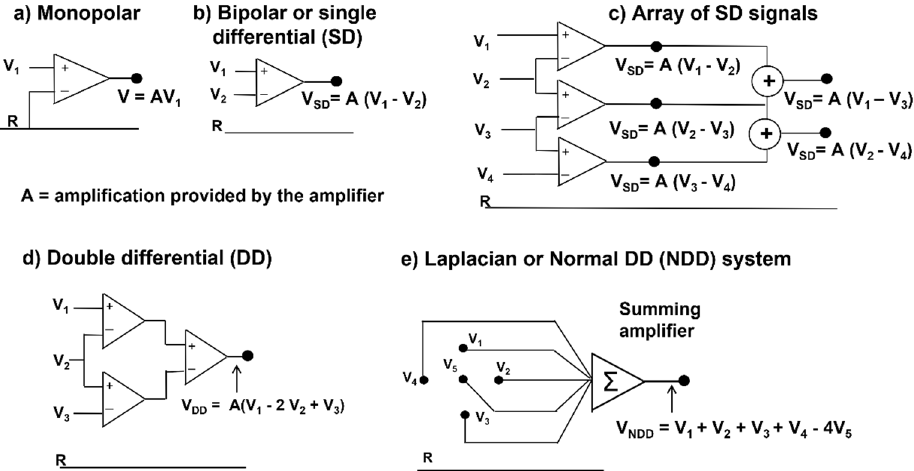
Figure 16. Electrode configurations or “montages”: ( a ) monopolar (any combination or spatial filter can be obtained by a grid of monopolar signals); ( b ) bipolar or single differential (SD); ( c ) array of SD signals; ( d ) double differential (DD); ( e ) normal (perpendicular) DD (NDD) or Laplacian configuration. Other configurations are possible. The reference electrode R must be on a region with no sEMG activity and away from the muscle of interest. It should not be on the same muscle. The NDD system is widely used in EEG because of its selectivity. Some recently developed systems do not need a reference electrode. A is the amplification or gain of the differential amplifier. Modified from https://www.robertomerletti.it/en/emg/material/teaching/module6.